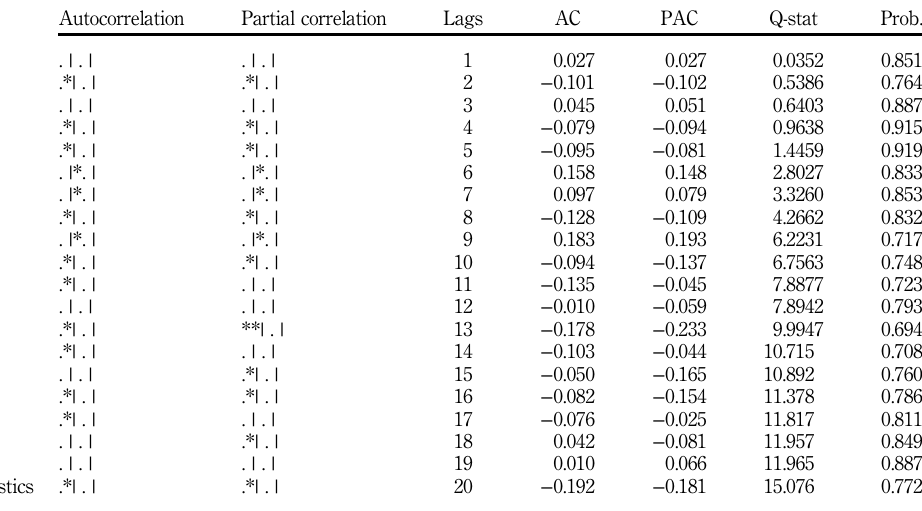
Table VII. Outcomes of correlogram